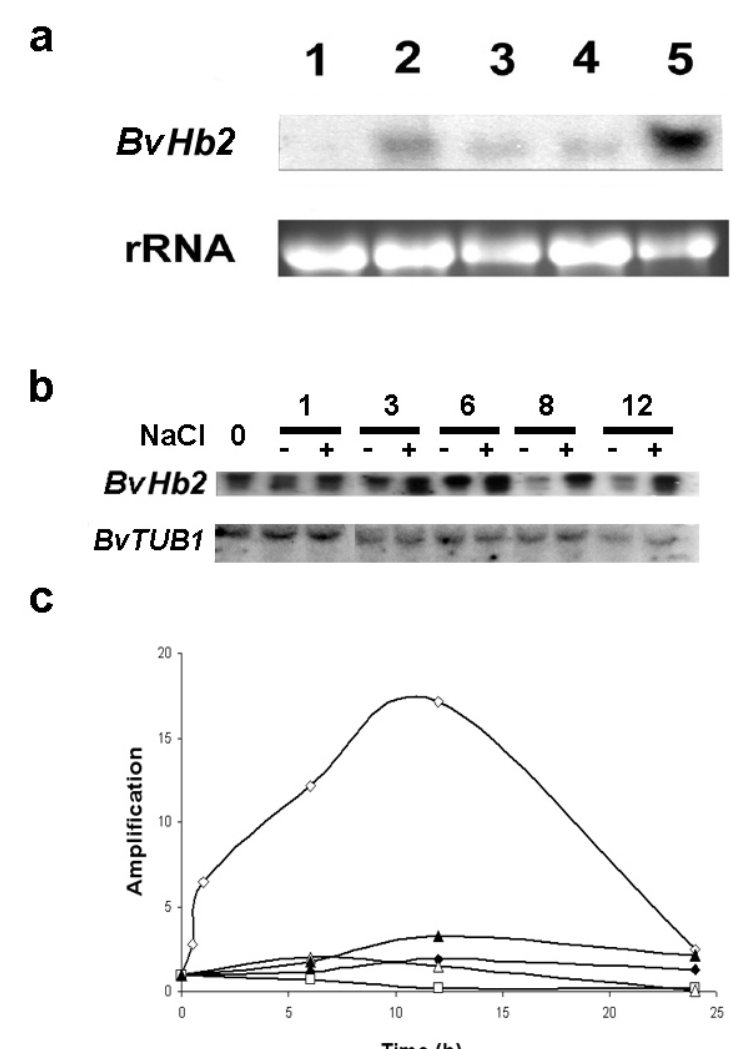
Figure 2. BvHb2 is mainly expressed in leaves and upregulated by stress and white light. ( a ) Northern blot analysis of total RNA (15 µ g) from root (1), hypocotyl (2), petiole (3), cotyledon (4), and leaf (5) from sugar beet. The lower panels show the amount of 26S rRNA loaded for each treatment (ethidium bromide staining). ( b ) Northern blot analysis of total RNA (15 µ g) from sugar beet leaves. RNA was isolated from 3-week-old sugar beet leaves at 0, 3, 6, 8, and 12 h after growing with ( + ) or without ( − ) 250 mM NaCl. The same RNA blot was hybridized with an α 3 tubulin probe ( BvTUB1 ) from B. vulgaris used as control of filter transfer. ( c ) Amplification of BvHb2 (fold change) determined by real time quantitative PCR in 3-week-old plants kept in the dark (filled diamonds) or exposed to white light (empty diamonds), blue light (filled triangles), red light (empty triangles), or far-red light (empty squares). For clarity errors bars were not included, but errors were less of 10% of the value ( n = 6).